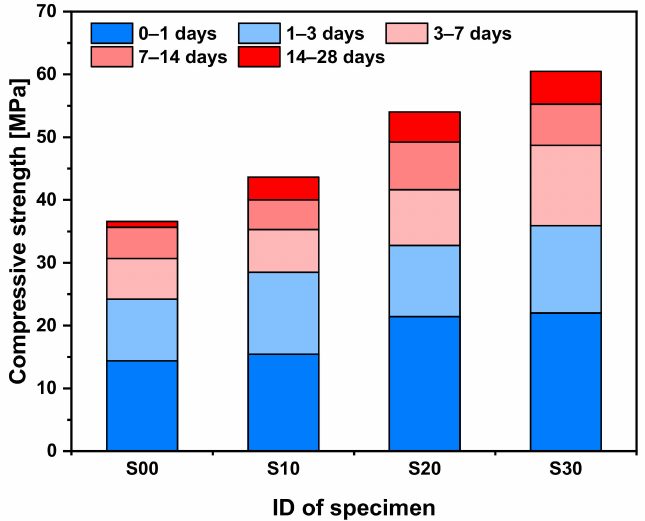
Figure 7. Compressive strength of cement mortar blended with